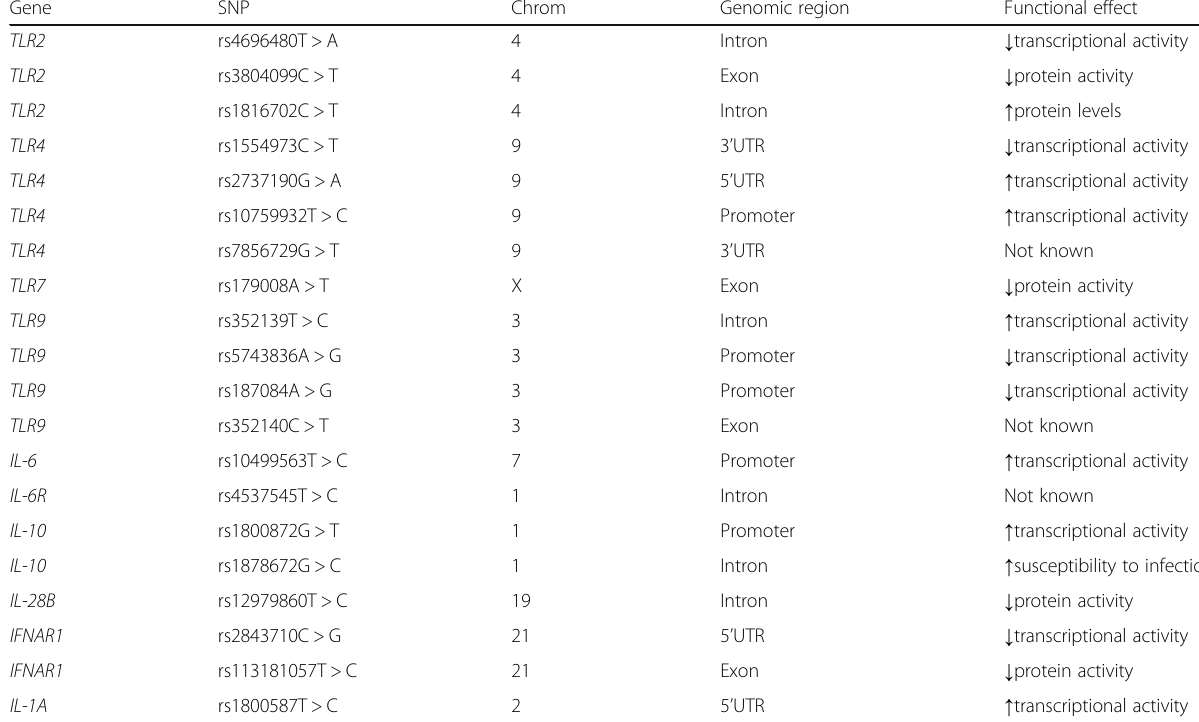
Table 1 Single nucleotide polymorphisms included in this study